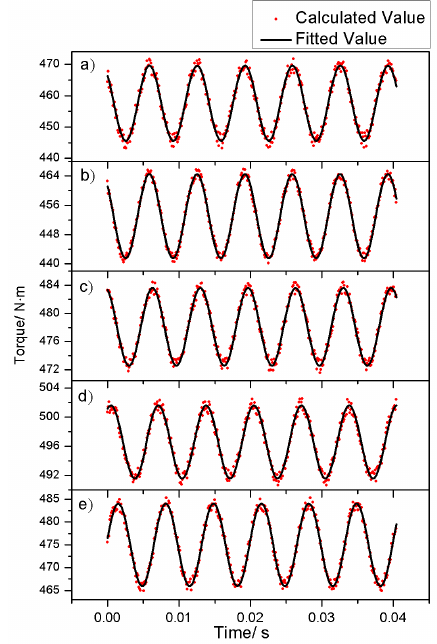
Figure 6. Fluctuation of torque in one shaft rotation cycle on different working points: ( a ) 0.6 Q des ; ( b ) 0.8 Q des ; ( c ) 1.0 Q des ; ( d ) 1.2 Q des ; ( e ) 1.4 Q des .